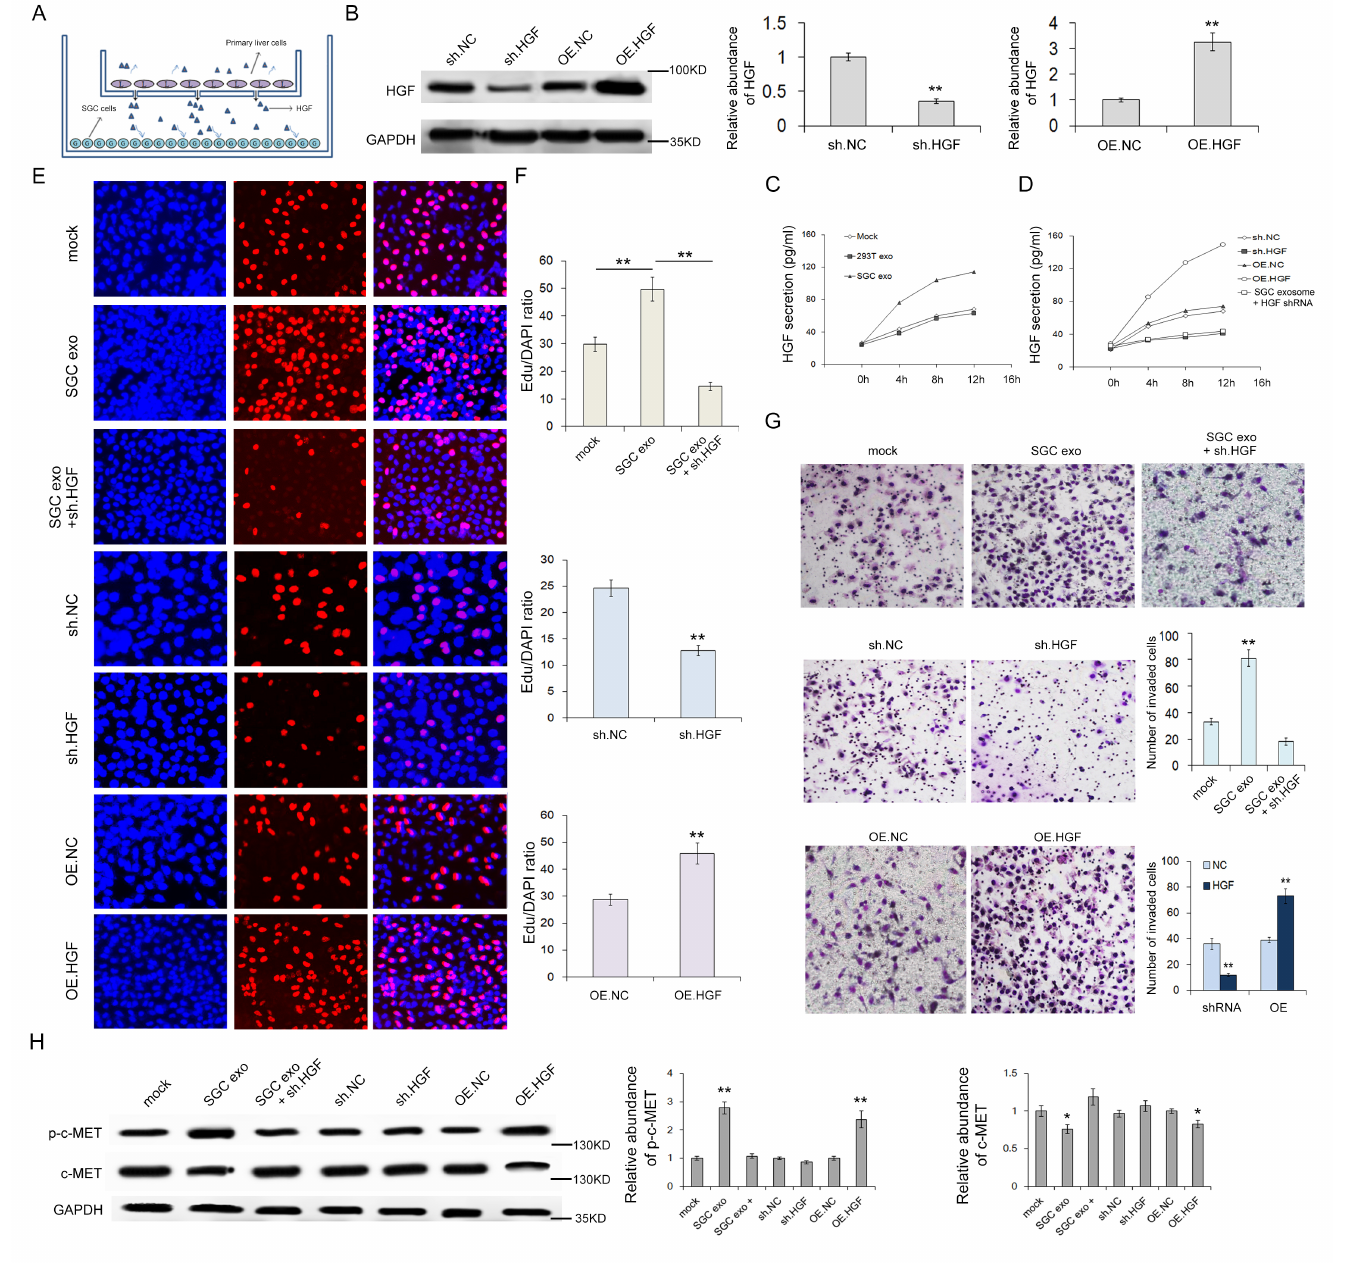
Figure 6 | Upregulated liver paracrine HGF promotes proliferation and invasion of SGC7901 cells. Pretreated mixed liver cells were co-cultured with SGC7901 cells using a 0.4 m m membrane and the biology behaviour of SGC7901 cells were measured subsequently. ( a ) Schematic representation of the in vitro model for cell co-culture. ( b ) Western blot analysis of HGF expression in primary liver cells treated with HGF shRNA and HGF-overexpressing lentivirus (OE.HGF) ( n ¼ 3). ( c ) Effects of SGC exosomes and control exosomes on the HGF secretion from mixed liver cells ( n ¼ 3). ( d ) ELISA analysis of HGF secretion from primary liver cells treated with HGF siRNA or OE.HGF lentivirus ( n ¼ 3). ( e – g ). Upregulated liver HGF promotes growth ( e ) and invasion ( g ) of SGC7901 cells ( n ¼ 3). ( h ) c-METand p-c-METexpression in mixed liver cells treated as above ( n ¼ 3). The data represent the mean ±